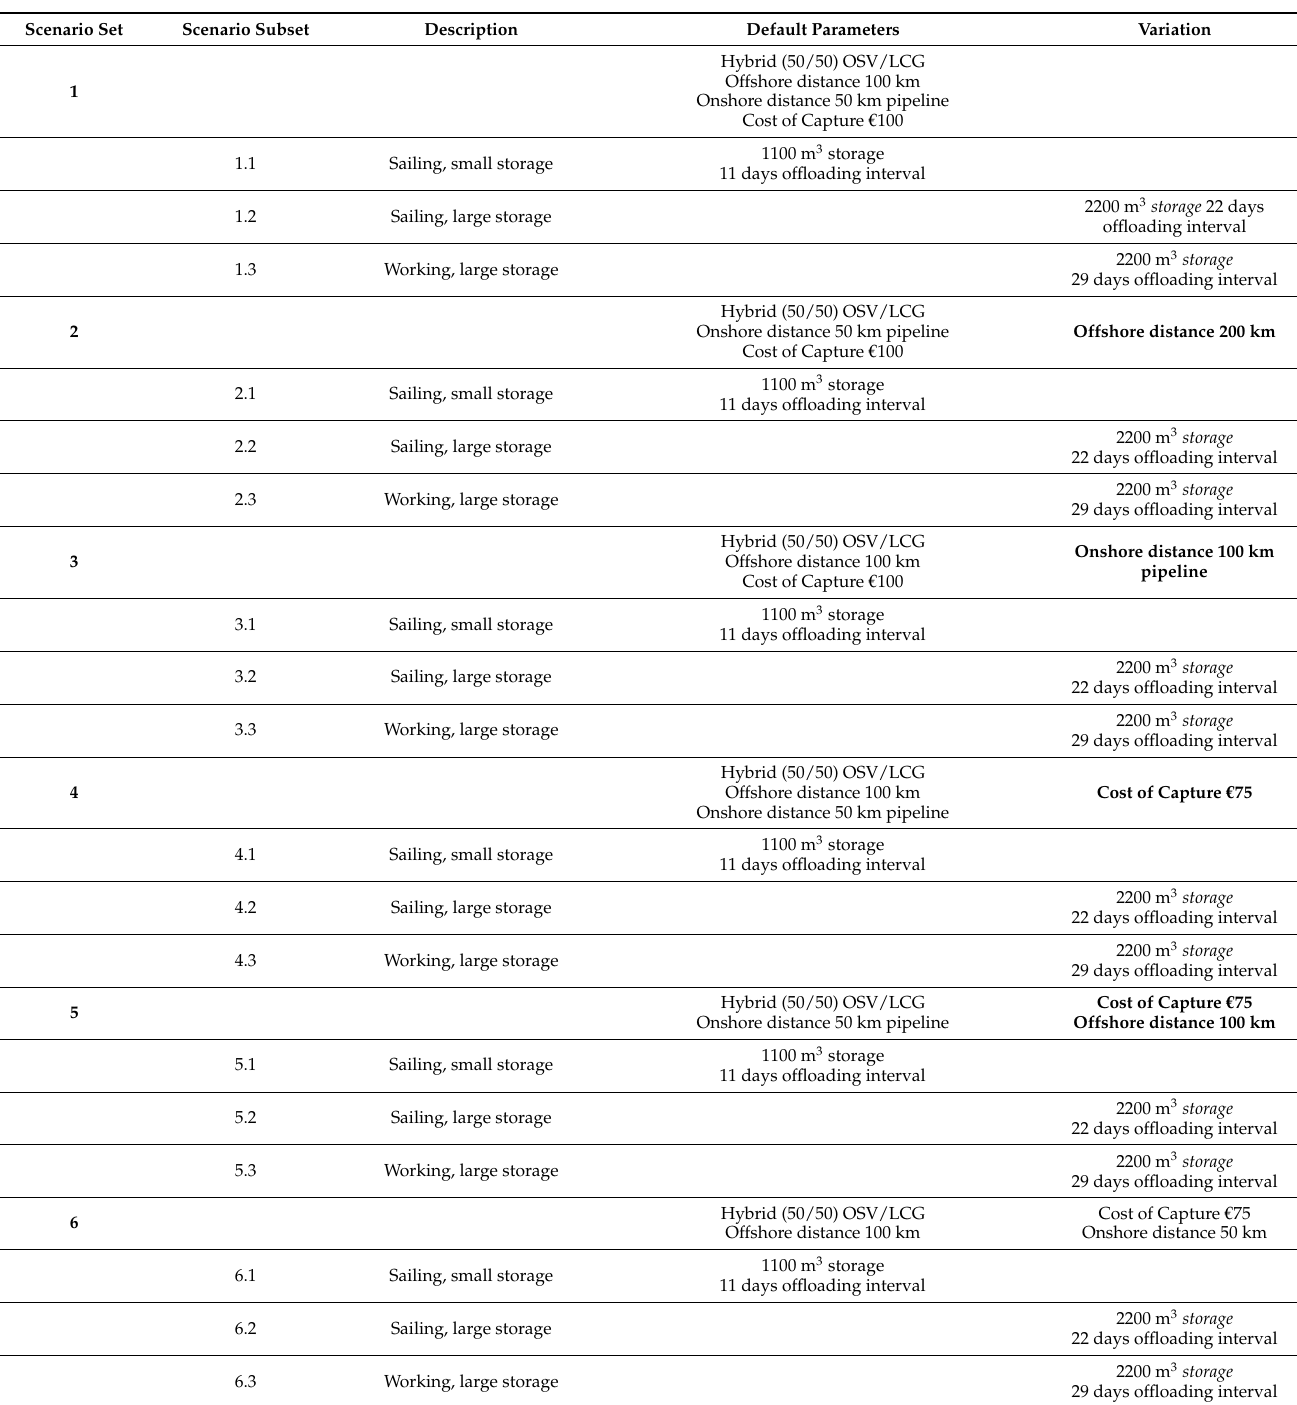
Table A3. Overview of scenario variations 1–6 first